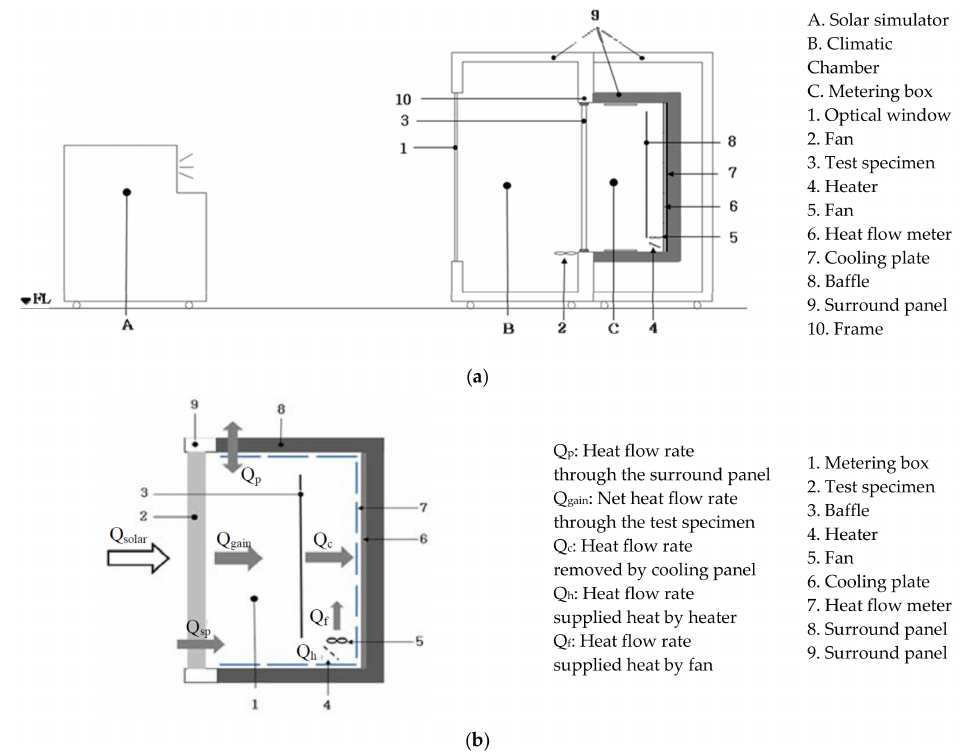
Figure 1. Solar Heat Gain Coefficient (SHGC) test rig [10]. ( a ) SHGC measurement apparatus; ( b ) Principle of solar heat gain measurement.